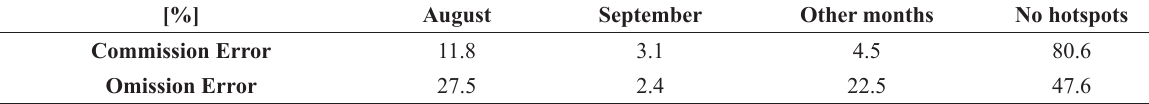
Monthly relative frequency of hotspots for OEs and CEs pixels [%].